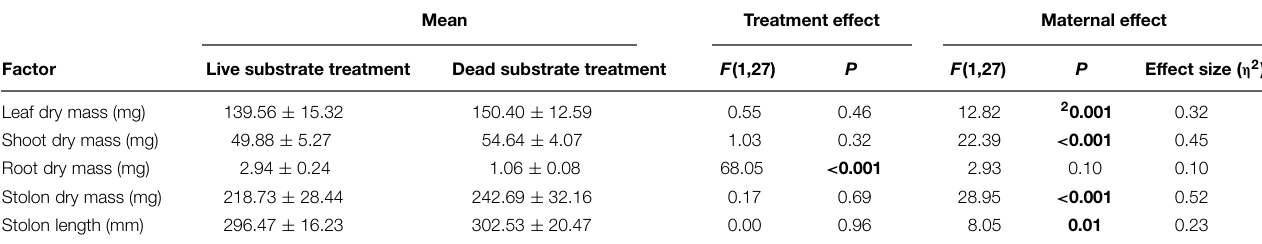
TABLE 1 | Analysis from the spring